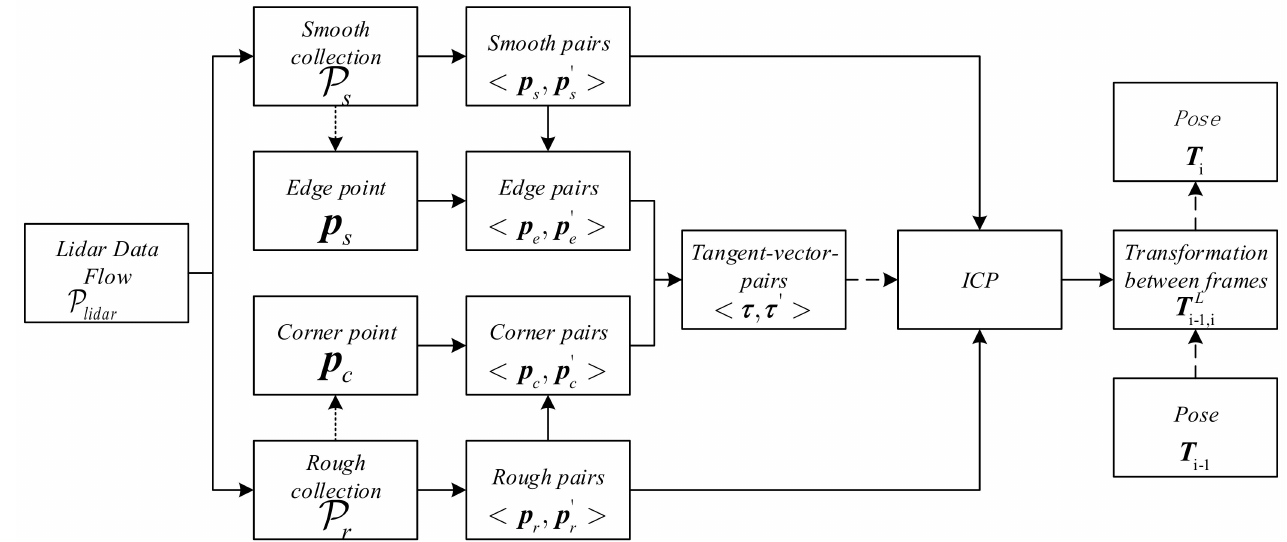
Figure 2. i represents the current frame, and i − 1 represents the previous frame. T L frame i and i − 1 in the coordinate system { L